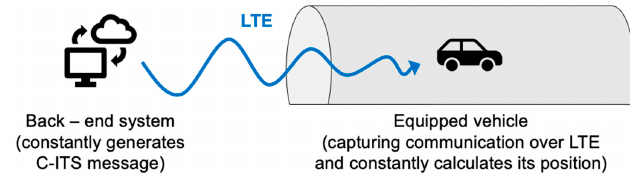
Figure 4. Schema of the pre ‐ test.